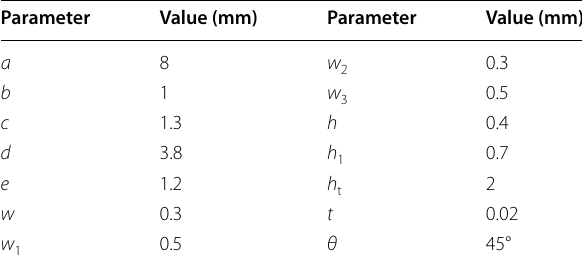
Table 1 Dimensions and parameters of the MA Parameter